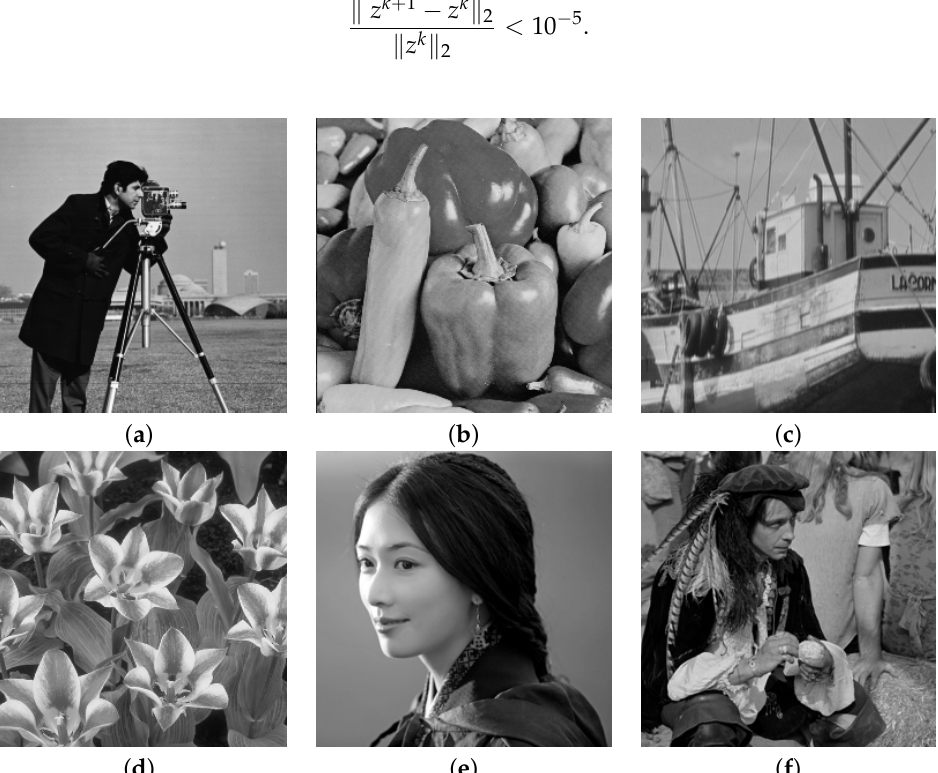
Figure 1. Test images: ( a ) Camera, ( b ) Peppers, ( c ) Boats, ( d ) Tulips, ( e ) Lin, ( f )